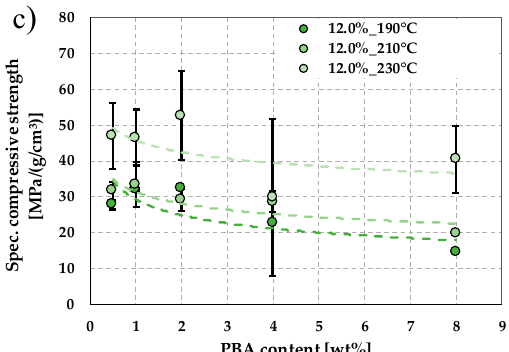
Figure 12. The specific compressive strength as a function of foaming agent content; specific compression strength of PLAs with ( a ) 1.4%, ( b ) 4.3%, and ( c ) 12.0% D -lactide content at different processing temperatures.